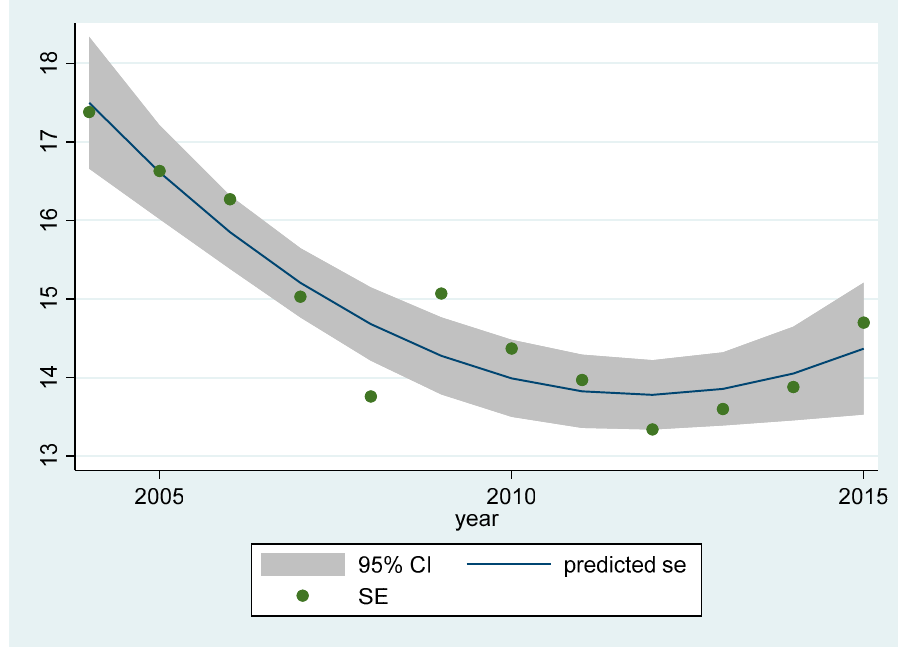
Figure 5. The average size of the shadow economy in Saudi Arabia Source: authors’ estimations.